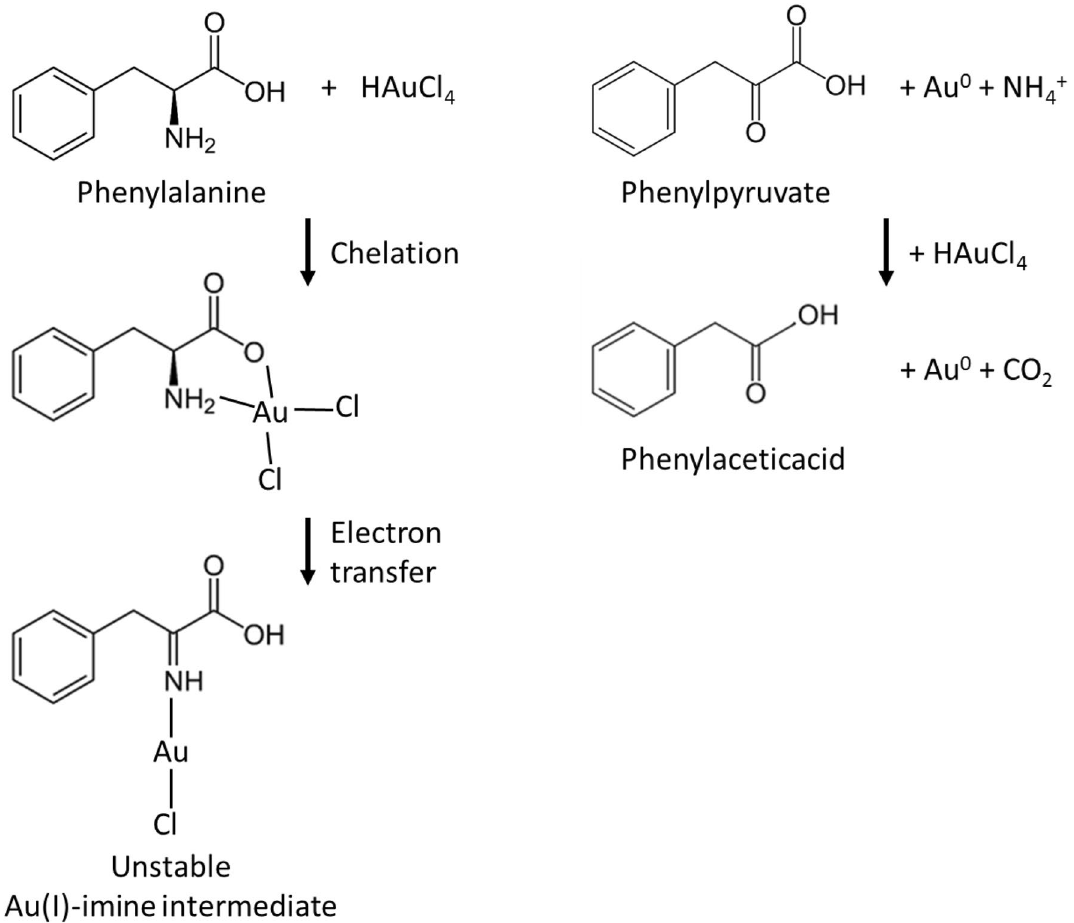
Figure 1. The proposed pathway of gold(III) reduction by